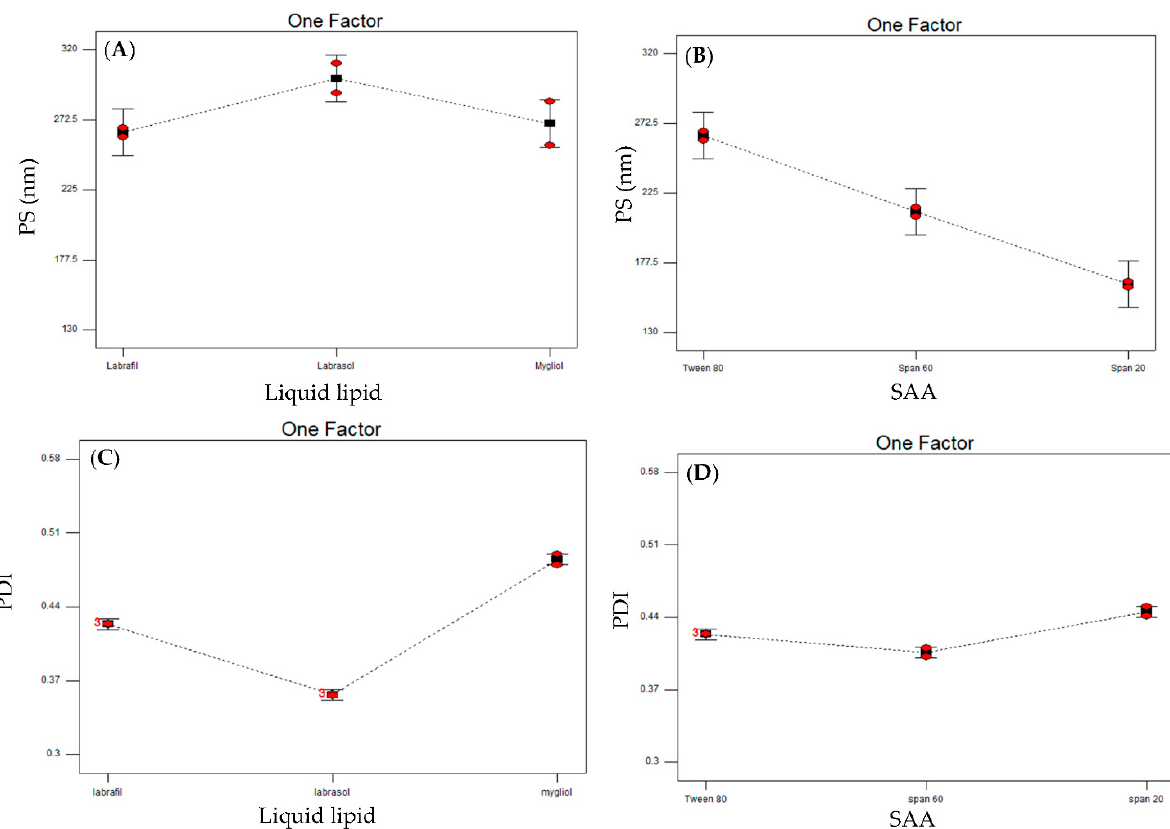
Figure 1. Line plots of the effect of the two significant studied variables: liquid lipid type on particle size ( A ), surfactant type on particle size ( B ), liquid lipid on polydispersity index ( C ) and surfactant type on polydispersity index ( D ).